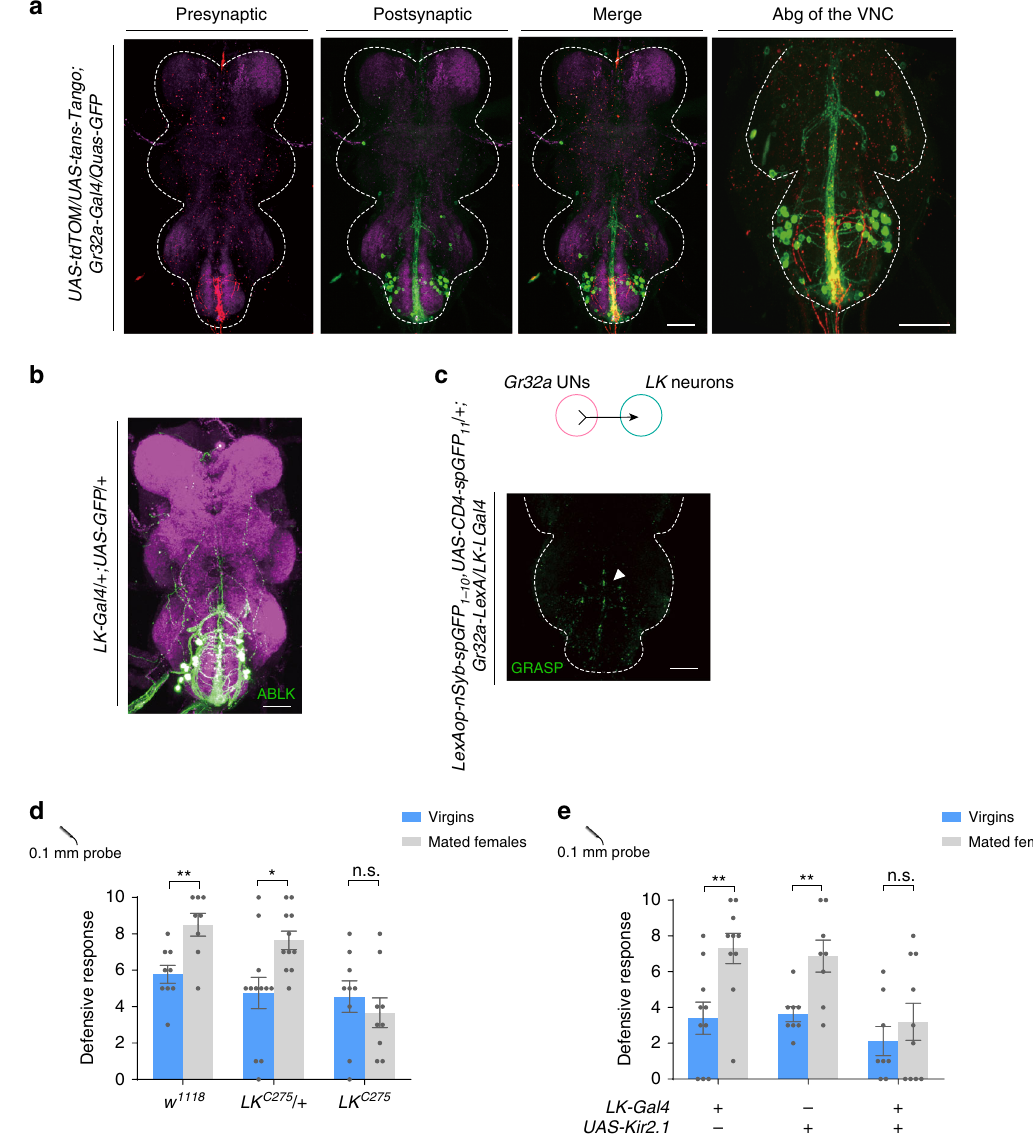
Fig. 5 LK neurons function downstream of UNs to mediate increased defensive response in mated females. a Putative second order neurons of UNs (red) revealed by trans-Tango (green). Magenta: nc82. Right panel: the abdominal ganglion (Abg) of the VNC was zoomed in. White dashed line outlines the border of the VNC. Scale bar represented 50 μ m. b Immuno fl uorescence of abdominal LK neurons (ABLK) (green) and nc82 (magenta). Scale bar represented 50 μ m. c GRASP signal (green) between UNs and LK neurons in the Abg. White dashed line outlines the border of the VNC. Scale bar represented 50 μ m. d , e Mutation of the LK gene d or silencing LK neurons with Kir2.1 e blocked the mating-induced defense facilitation. n = 9, 8, 12, 11, 9, 9 (from left to right) in d , n = 10, 10, 8, 8, 9, 8 (from left to right) in e . Error bars indicate mean ± SEM, ** p < 0.01, * p < 0.05, p > 0.05 (n.s.), n.s., not signi fi cant, two-tailed unpaired t tests. Source data are provided as a Source Data fi